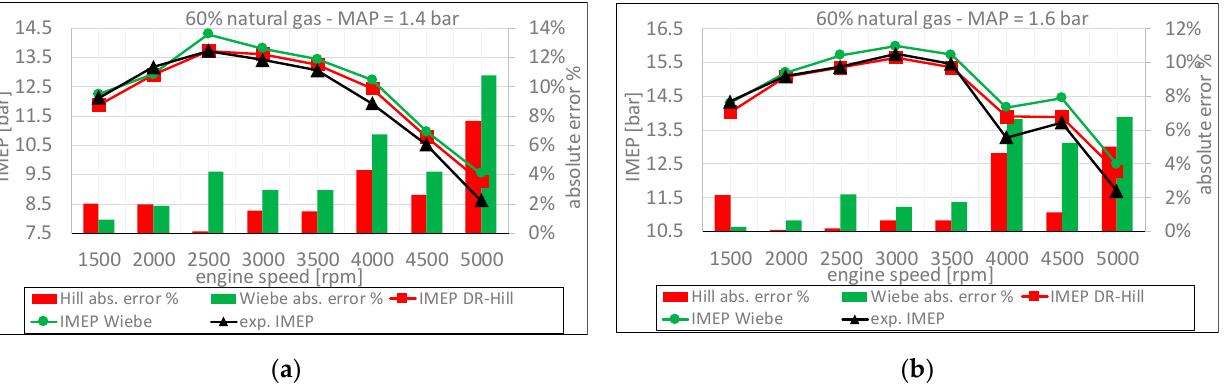
Figure 5. comparison between the experimental and simulated IMEP; 60% NG fuel mixture. ( a ) MAP = 1.4 bar; ( b ) MAP = 1.6 bar.